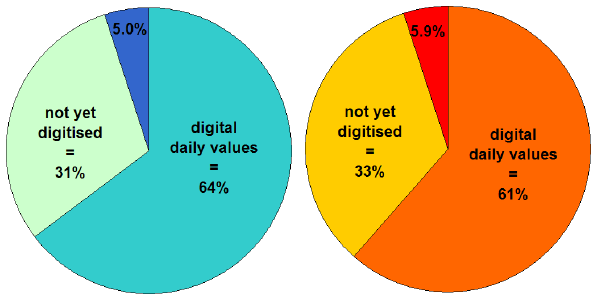
Figure 4. Fraction of the digitally available daily data, the data not yet digitized (the potential for digitization) and the amount digitized data by the KLIDADIGI initiative until the end of 2014 of the entire amount of data for precipitation (left) and temperature (right) series.